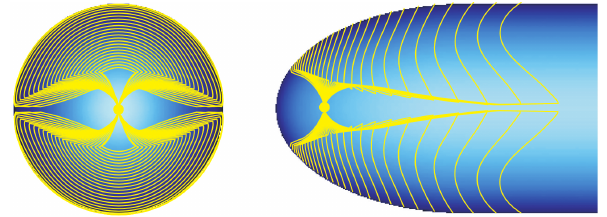
Fig. 4. Global geometry of the R1 FACs in the T02/TS05 models, shown in two projections. Left: view along the x axis (from Sun); right: side view along the y axis. The electric current flow lines Fig.4. GlobalgeometryoftheR1FACsintheT02/TS05models,shownintwoprojections. Left: viewalong theX-axis(fromSun); right: sideviewalongtheY-axis. Theelectriccurrentflowlines(yellow)closeviathe (yellow) close via the model magnetopause (blue shading). modelmagnetopause(blueshading). Fig. 5. Illustrating the fast Biot–Savart integration method. Fig. 5. Illustrating the fast Biot-Savart integration method.